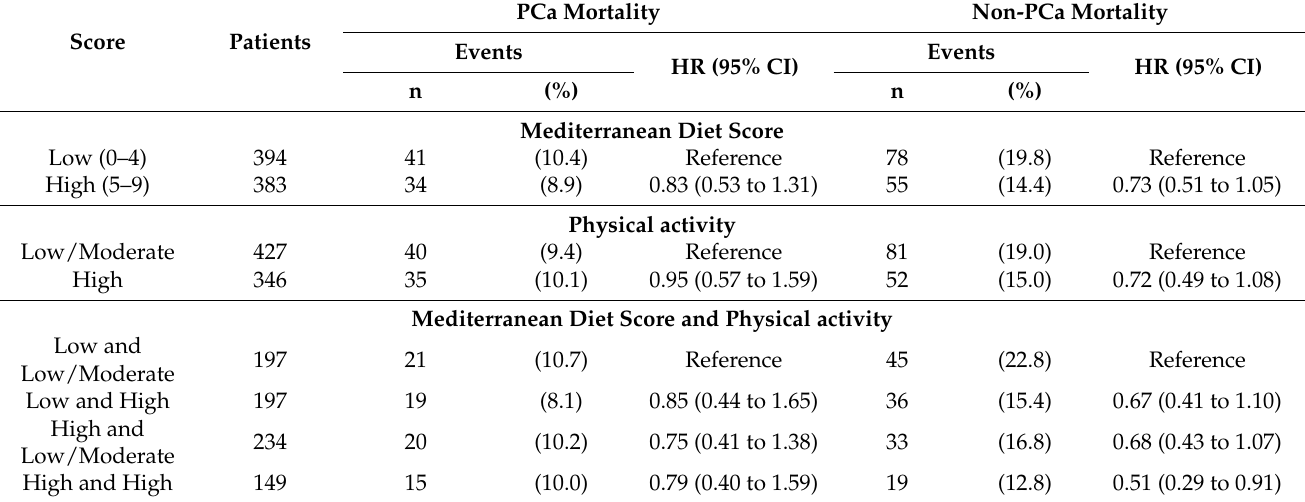
Table 3. Hazard ratios (HR) a for prostate cancer (PCa) and non-PCa mortality, with corresponding 95% confidence intervals (CI), among 777 men diagnosed with prostate cancer, according to adherence to Mediterranean Diet Score and physical activity. Italy,